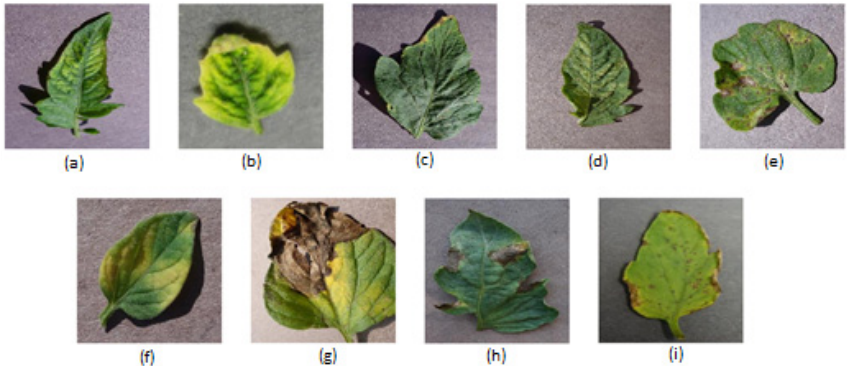
Figure 1. Representative images of the most common diseases affecting tomato leaves: ( a ) mosaic virus, ( b ) yellow leaf curl virus, ( c ) target spot, ( d ) two-spotted spider mite, ( e ) septoria leaf spot, ( f ) leaf mold, ( g ) late blight, ( h ) early blight and ( i ) bacterial spot.